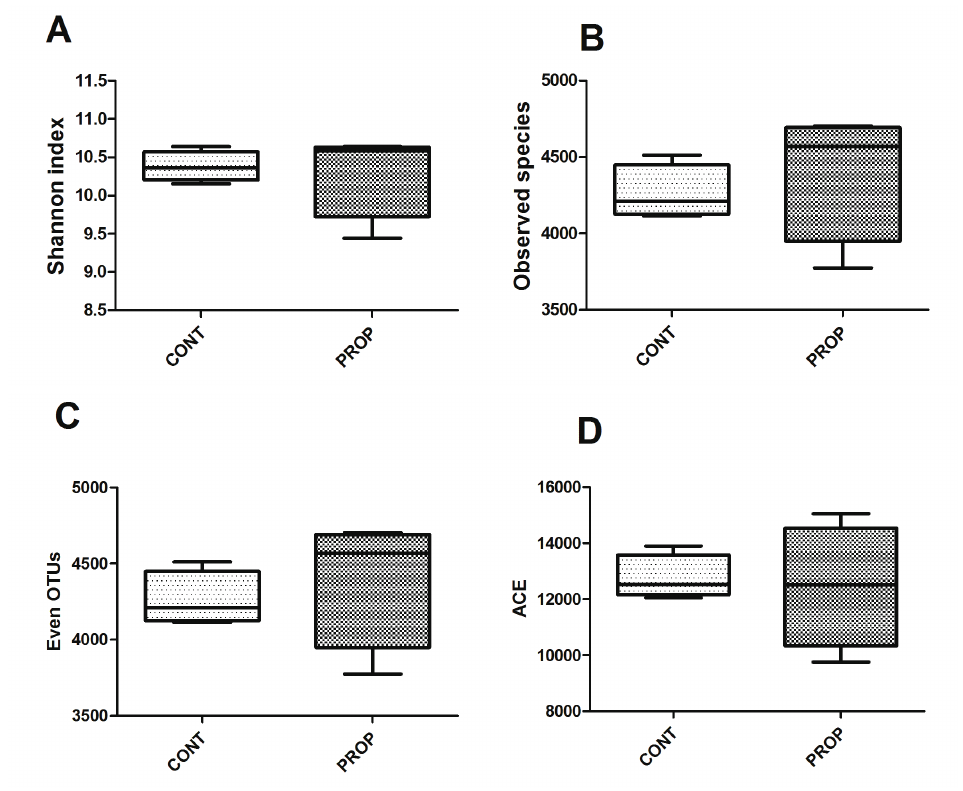
Figure 3. Differences in OTUs of ruminal bacteria between the control feeding group (CONT) and calcium propionate supplementation feeding group (PROP). (A) Venn diagram showing the number of shared OTU between feeding groups. (B) Principal coordinate analysis (PCoA) of bacterial community structures of the ruminal microbiota of the two groups. The PCoA plots were constructed using the unweighted UniFrac method. Blue squares and red circles represent PROP and CONT feeding group samples, respectively. (C) Thermal double dendrogram of the most abundant bacterial operational taxonomic units (OTU).